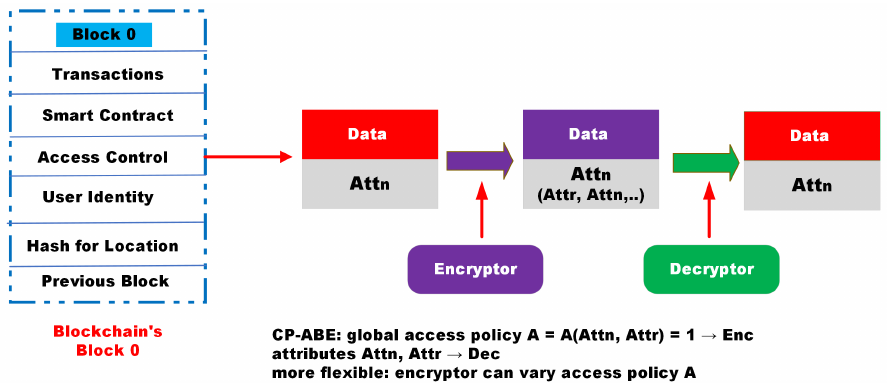
Figure 3. Attribute-based encryption/decryption techniques in